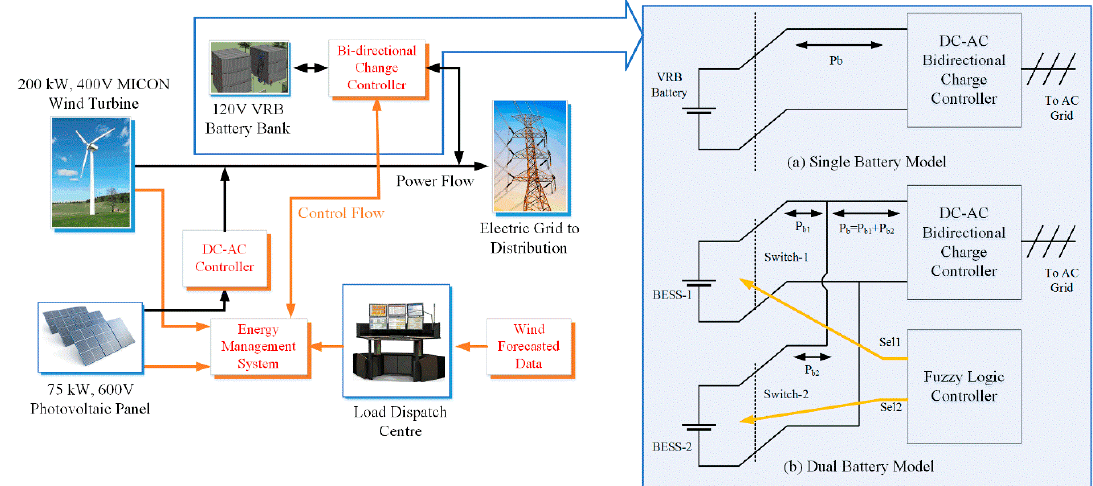
Figure 1. ( a ) Wind-Photovoltaic-Vanadium Redox Battery (VRB) Hybrid Renewable Energy System (HRES) ( b ) Subsection showing architecture for Single and Dual VRB battery modules as proposed.